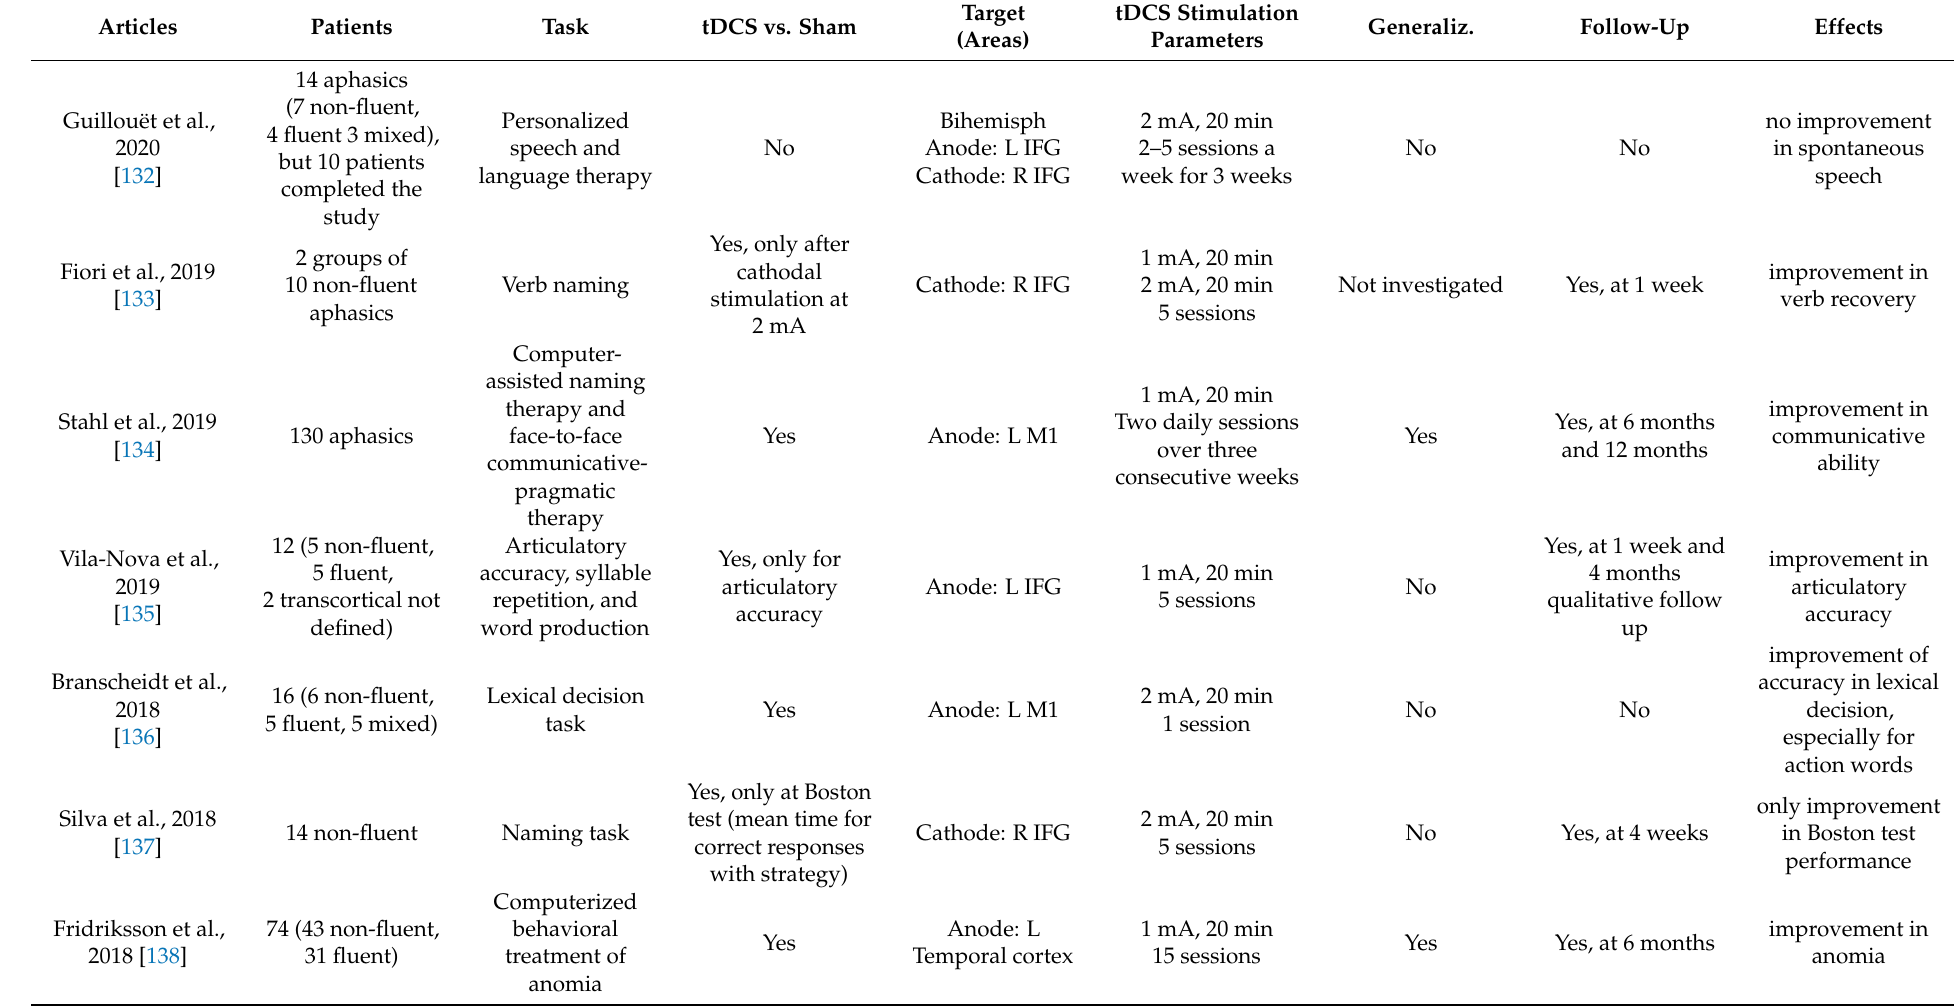
Table 3. Transcranial direct current stimulation studies in aphasia recovery. Abbreviation: L left; R: right; IFG: inferior frontal gyrus; ST: superior temporal; M1: motor cortex; PPR: posterior perisylvian region; DLPFC: dorsolateral-prefrontal cortex, Bihemisph: bihemispheric; Generaliz: generalization; Periles: perilesional; Individ: Individualized. Articles tDCS vs. Sham